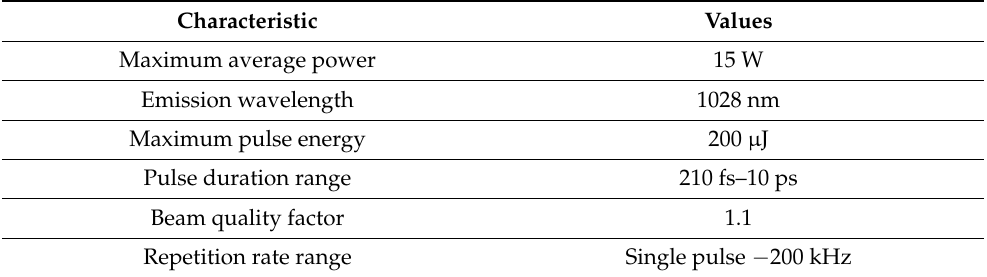
Table 1. Main characteristics of the femtosecond laser source used in the texturing experiments.